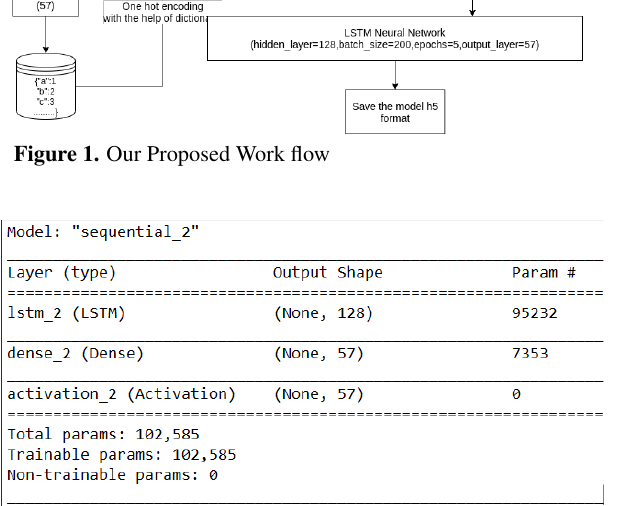
Figure 2. Neural network Architecture